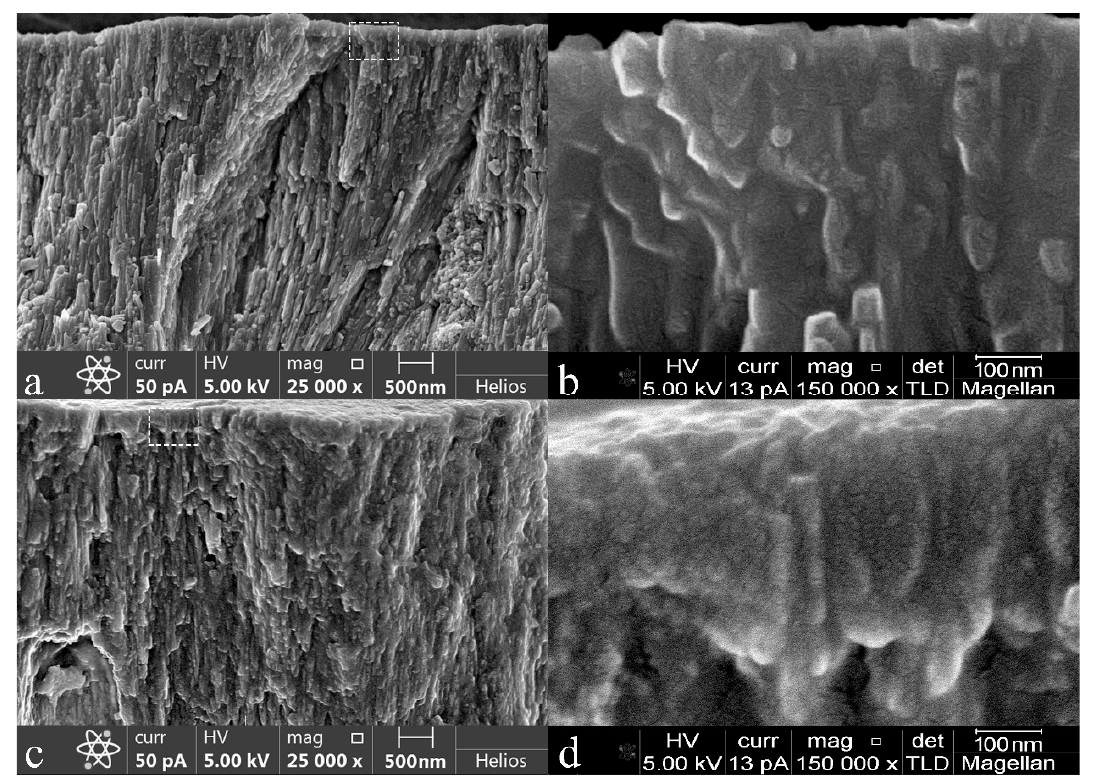
Figure 6. Typical cross-section SEM images of mineralized tooth tissue: ( a , b ) healthy tooth enamel without treatment (sample N1); ( c , d ) after surface pretreatment with Ca(OH) 2 and an amino acid booster, with subsequent mineralization (sample N5).